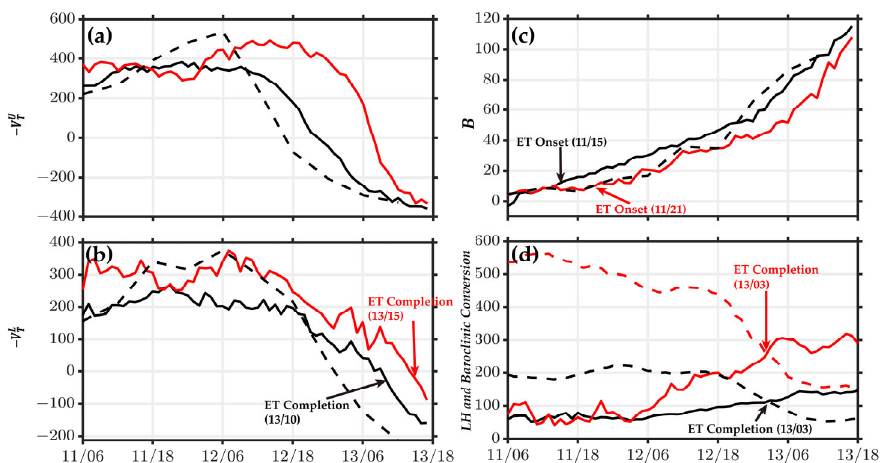
Figure 2. Three cyclone phase space (CPS) parameters, ( a ) − V U , ( b ) − V L , and ( c ) B, of Songda in simulations (black solid lines for the control and red solid lines for SST4.5) and NCEP GDA/FNL data (black dashed lines; 6 h interval). ( d ) The spatial average of the surface latent heat (dashed lines; W m (cid:2879)(cid:2870) ) and baroclinic conversion ( −𝜔 (cid:4593) 𝛼 (cid:4593) ; solid lines; W m (cid:2879)(cid:2870) ). The black lines are for the control, and the red lines are for SST4.5. The D2 output is utilized (1 h interval). The arrows indicate the onset and completion of ET diagnosed by the two methods.